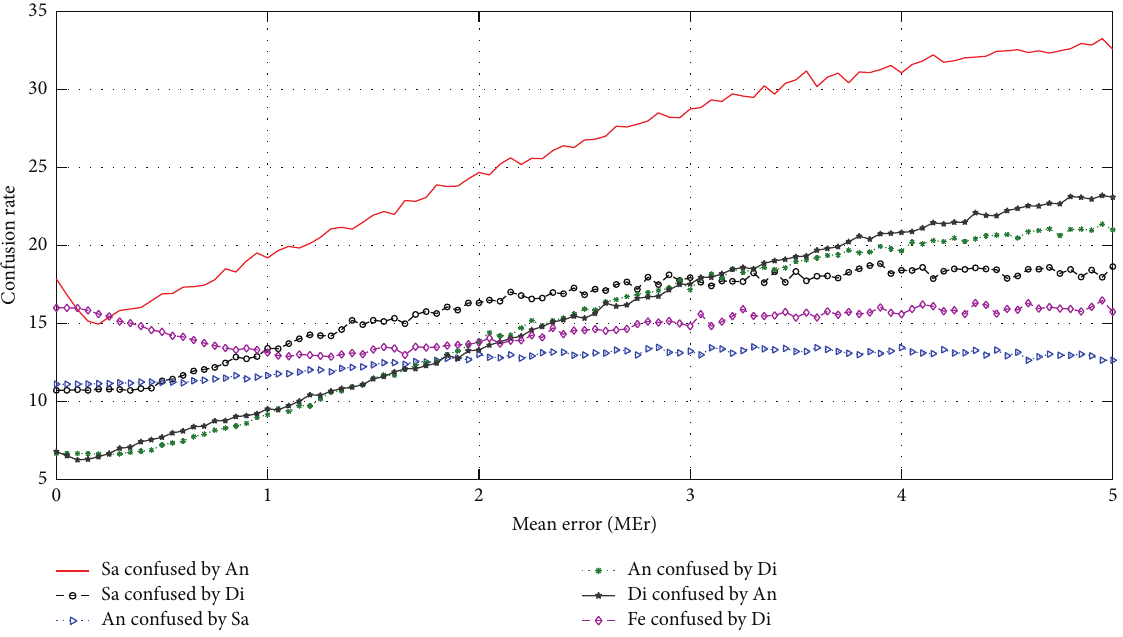
Figure8:Themostfacialexpressionconfusedratesversusthesynthesizederrorinthefacialpointlocalization.Theexperimentwasconducted on CK+ database with SVM classifier. MEr is the Euclidean distance between the detected point and the ground truth divided by width of the detected face. For example, sadness is most confused for anger (Sa confused by